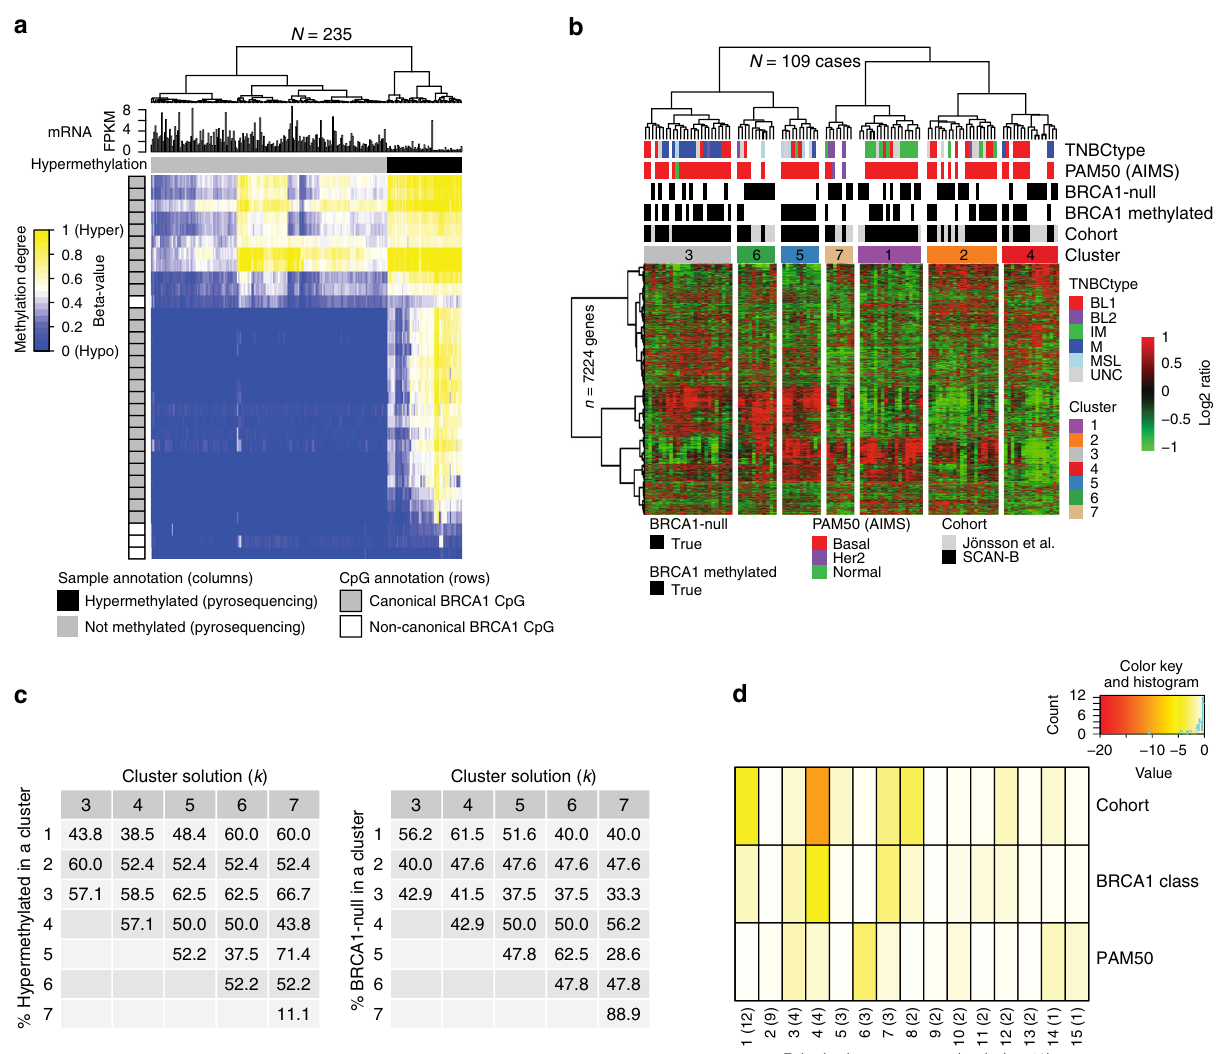
Fig. 5 DNA methylation and transcriptional characteristics in BRCA1 hypermethylated and BRCA1 -null TNBC. a Hierarchical clustering (ward.D2 linkage, Euclidean distance) of DNA methylation data (beta-values, heatmap) from 235 SCAN-B cases for 32 CpGs associated with the BRCA1 gene. The 32 CpGs were differentially methylated between 25 BRCA1 -null and 57 BRCA1 hypermethylated SCAN-B cases through supervised analysis of Illumina EPIC data. Black sample annotations correspond to hypermethylated cases by pyrosequencing, gray to unmethylated. Gray CpG annotation bars (rows) indicate belonging to the canonical BRCA1 promoter ( + 500 to − 1500 base pairs, chr17:43124984 – 43126983). BRCA1 mRNA expression (FPKM) is shown for each case as bar plot expression above the CpG heatmap. b Unsupervised hierarchical gene expression-based clustering of 52 BRCA1 -null and 57 BRCA1 hypermethylated cases combined from the SCAN-B and Jönsson et al. 23 cohorts using Pearson correlation as distance and Ward.D linkage based on 7224 genes with standard deviation >0.6 in mean-centered expression across all samples. Colored boxes indicate the seven top subclusters de fi ned from the hierarchical tree. TNBCtype subtypes 31 ; BL1, basal-like 1: BL 2, basal-like 2: IM, immunomodulatory: M, mesenchymal: MSL, mesenchymal stem-like: UNC, uncertain. PAM50 and TNBCtype subtypes were not available for the Jönsson et al. cases. c Summarized results from consensus clustering, using a range between 3 and 7 cluster solutions (k, columns) and the same gene set and samples as in ( b ). For each cluster solution, the percentage of BRCA1 hypermethylated (left matrix) and BRCA1 -null (right matrix) cases in the different de fi ned clusters are shown (rows). d Principal component analysis based on the expression of the 7224 genes to relate variance in gene expression with BRCA1 status. A more intense red color for a principal component (columns) with a variable (rows) implies a stronger association with variance in expression for that component. Components represent variation in decreasing strength ( fi rst component largest variation with contributed percentage variation listed). A variable strongly associated with variation in expression is thus represented by an intense red principal component capturing a high percentage of the variation. All p values reported from statistical tests are two-sided. Source data are provided as a Source Data fi